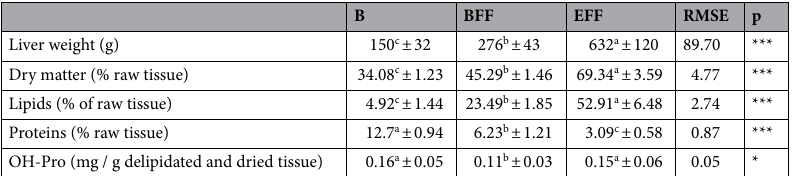
Table 1. Chemical composition of the analyzed livers harvested before (B), at the beginning (BFF) or at the end (EFF) of the force-feeding period. RMSE root-mean-square error, OH-Pro hydroxyproline. Values are means ± SD. Means with the same superscripts (a, or b, or c) are not different (p < 0.05). *** = p < 0.001, * = p <